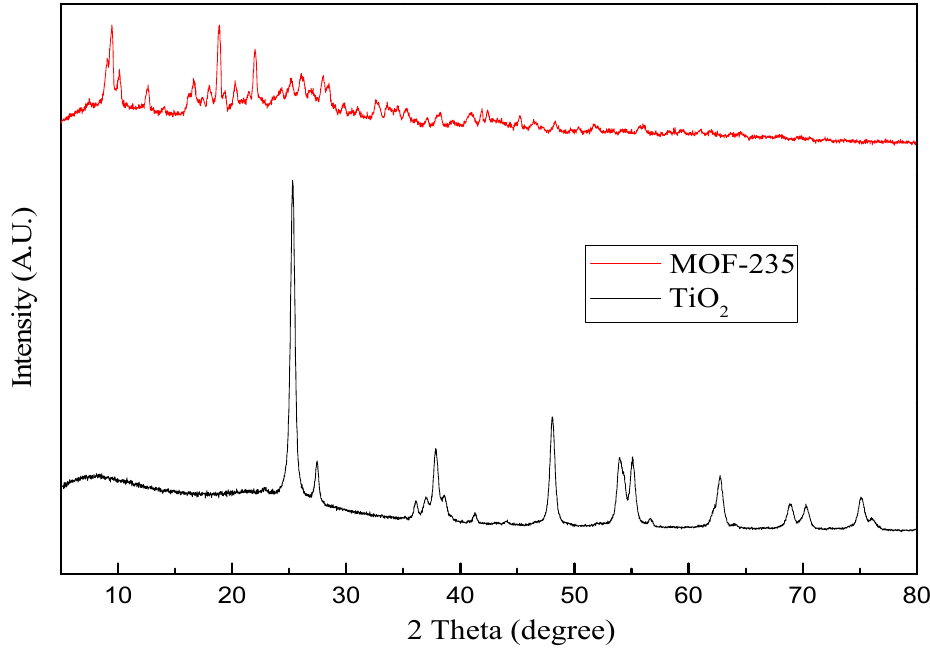
Figure 2. XRD patterns of the MOF-235 and TiO 2 -P25 mesoporous composite.